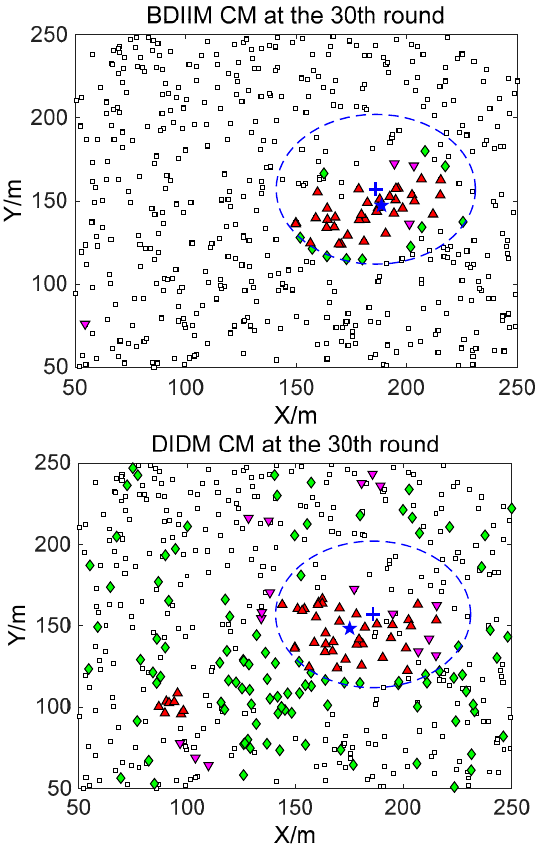
Figure 9. The state of the CM at the 20th time interval.